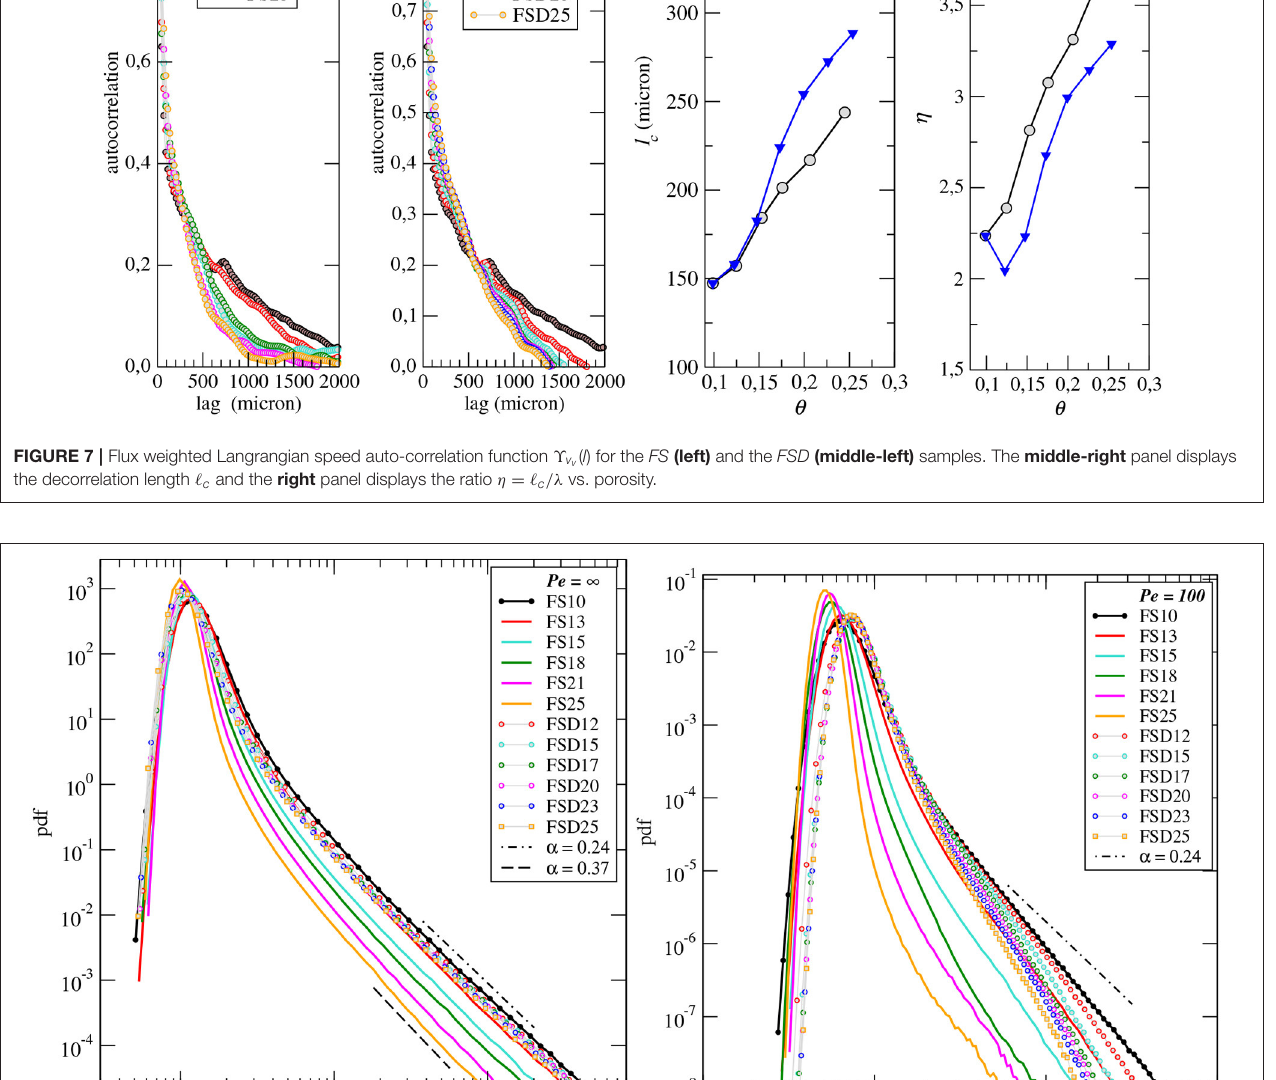
FIGURE 8 | First passage time PDF f t at Z = 5.47 × 10 − 2 m from the inlet. Left : results for infinite Pe vs. dimensionless time Z / v . Right : results for Pe = 100 vs. time.